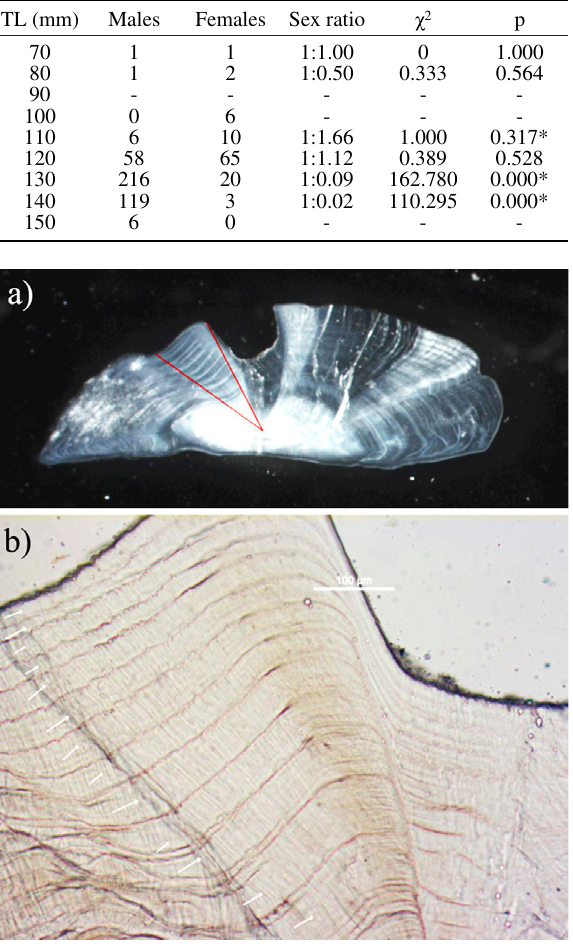
Table 2. – Number of males and females of S. lurida by 10 mm size (TL) class intervals; the chi-square statistic to test for significant de- partures of the sex ratio from the hypothetical 1:1 ratio are included. *, significant for p<0.05.